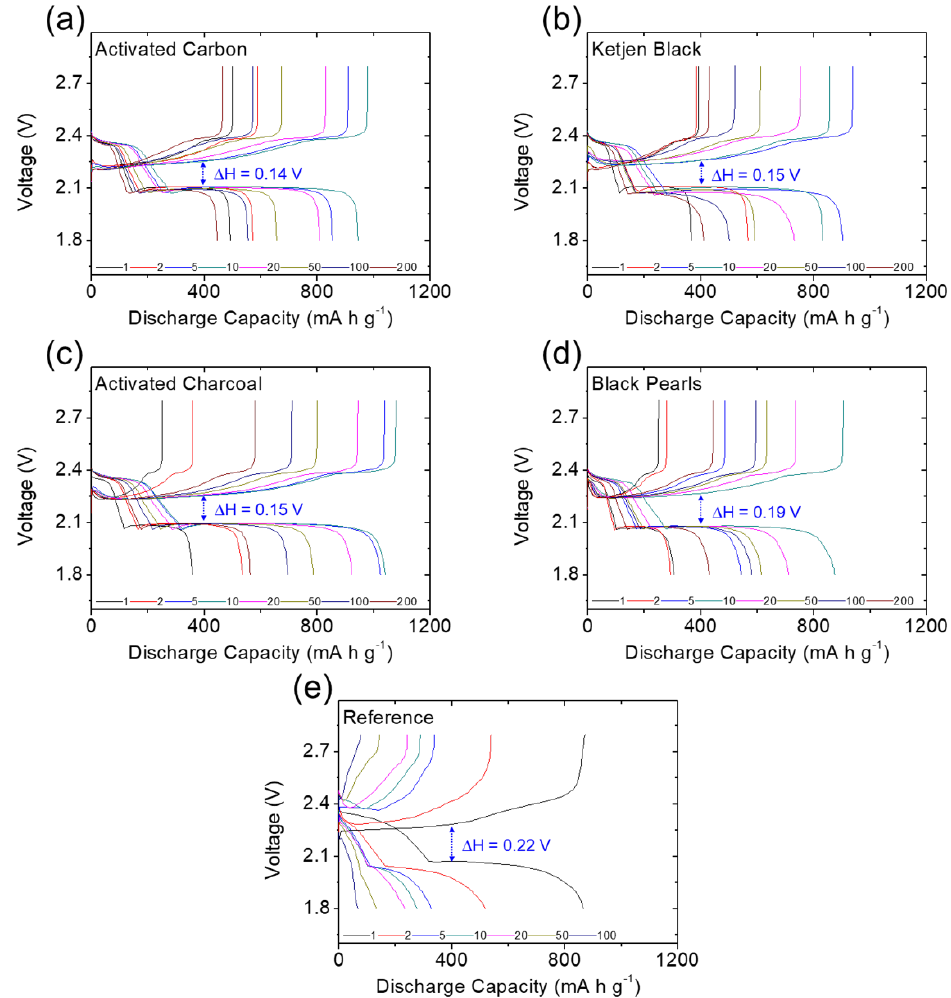
Figure 4. Electrochemical analysis: galvanostatic charge/discharge voltage profiles of the high-loading sulfur cathode in the lean-electrolyte cells with different carbon coating modules of ( a ) activated carbon, ( b ) Ketjen black, ( c ) activated charcoal, ( d ) Black Pearls, and ( e ) an uncoated reference cell.